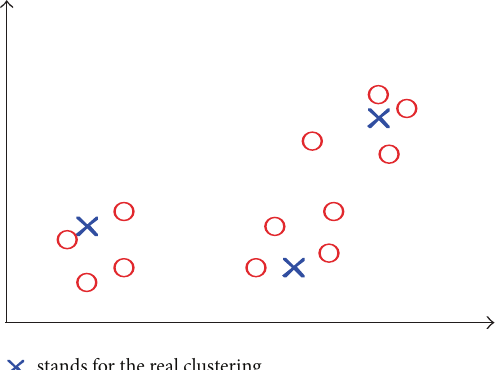
stands for the real clustering